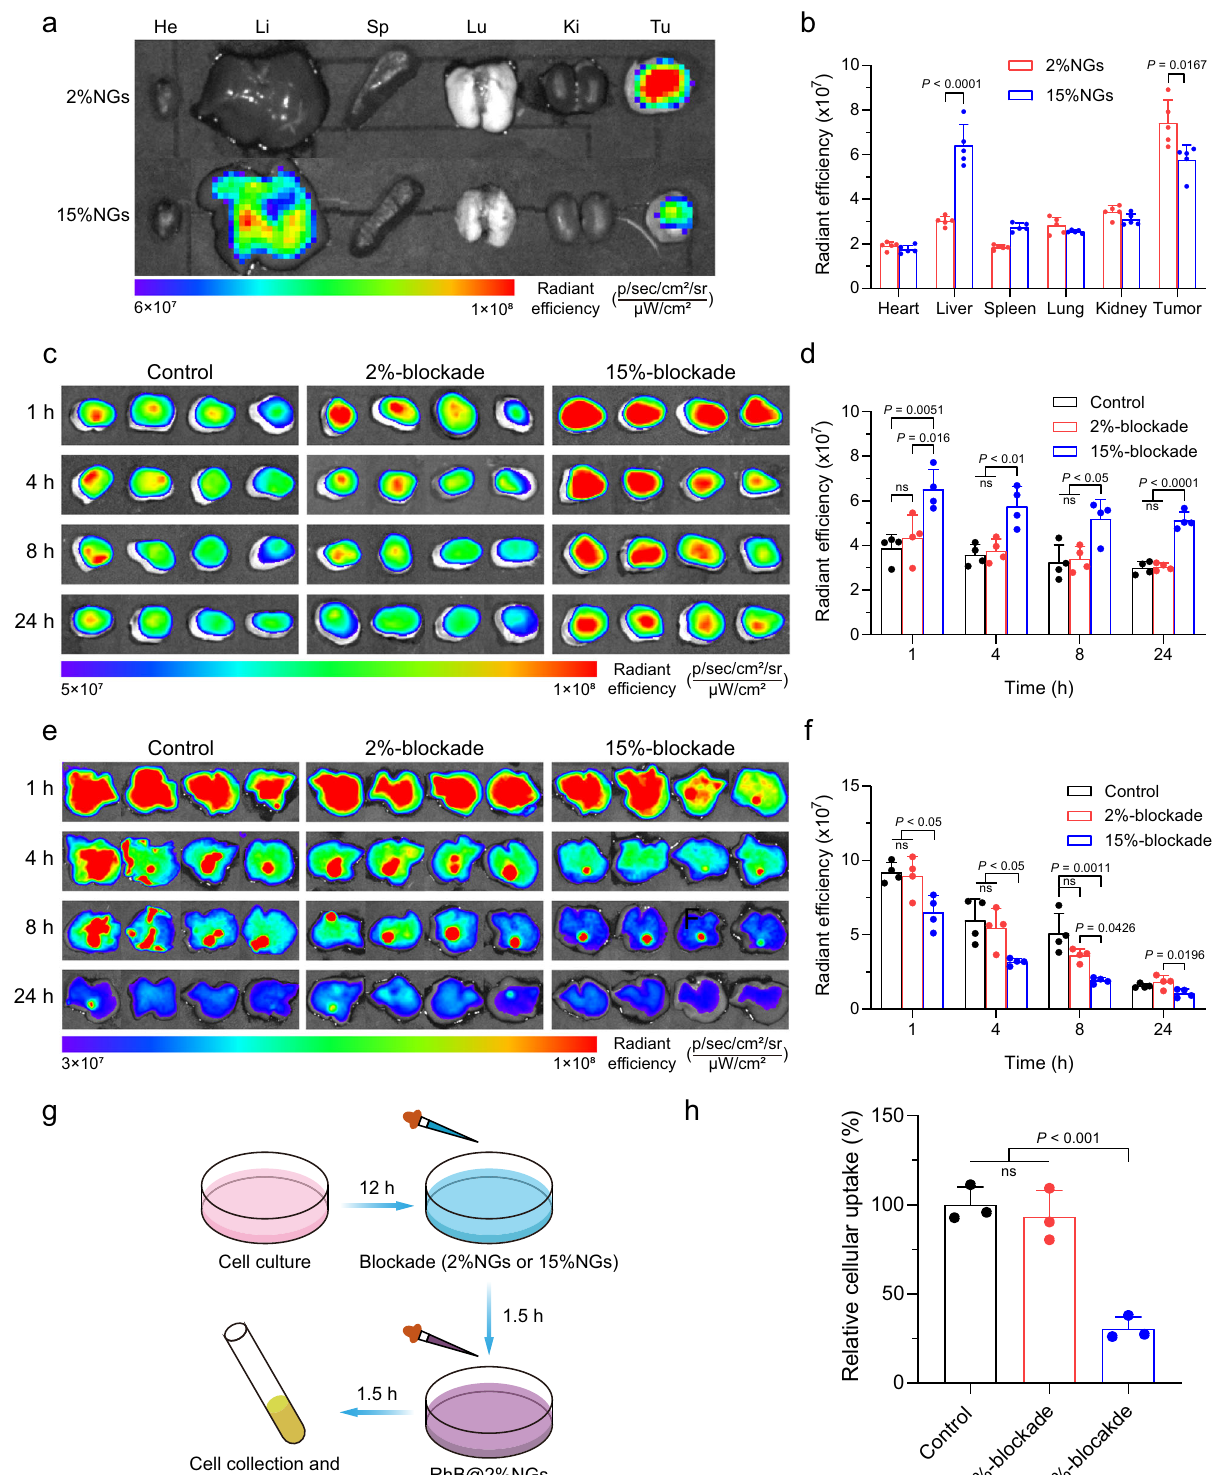
Fig. 4 | Advantages of stiff nanogels in RES-blockade. a Ex vivo fl uorescent images of biodistribution of ICG-loaded nanogels with different stiffness at 24h after injection. He heart, Li liver, Sp spleen, Lu lung, Ki kidney, Tu tumor. b Semi- quanti fi cation of the quantity of ICG-loaded nanogels with different stiffness in tumor and major organs ex vivo. Data are presented as mean values±SD ( n =5 biological independent replicates). Ex vivo fl uorescent images of ( c ) tumor accu- mulation and ( e ) liver accumulation of ICG-loaded 2%NGs after RES-blockade by nanogels with different stiffness at dosage of 200mg/kg. Semi-quanti fi cation of